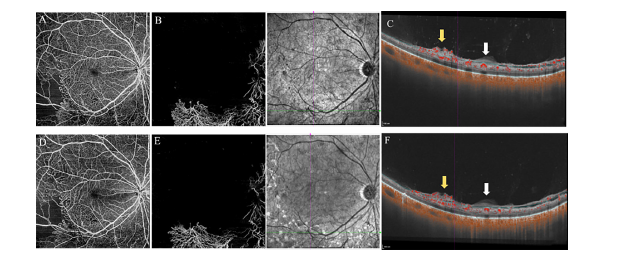
FIGURE 2 12×12mm SS-OCTA slabs of the retina (A, D) , VRI (B, E) , and B-scan images (C, F) showed features of PDR eyes at baseline (top) and 3-month follow-up (bottom). The area of NVs was reduced from 14.77mm 2 (B) to 13.11mm 2 (E) after PRP treatment (measured by Angiotool, Version 0.6a). B-scan images revealed no PVD around the location of NVs at baseline and after PRP treatment. White arrows indicated the thickened posterior vitreous (PVC). Yellow arrows indicated the NVs. VRI, Vitreoretinal Interface; PVD, posterior vitreous detachment; NVs, Neovascularization; PRP, panretinal